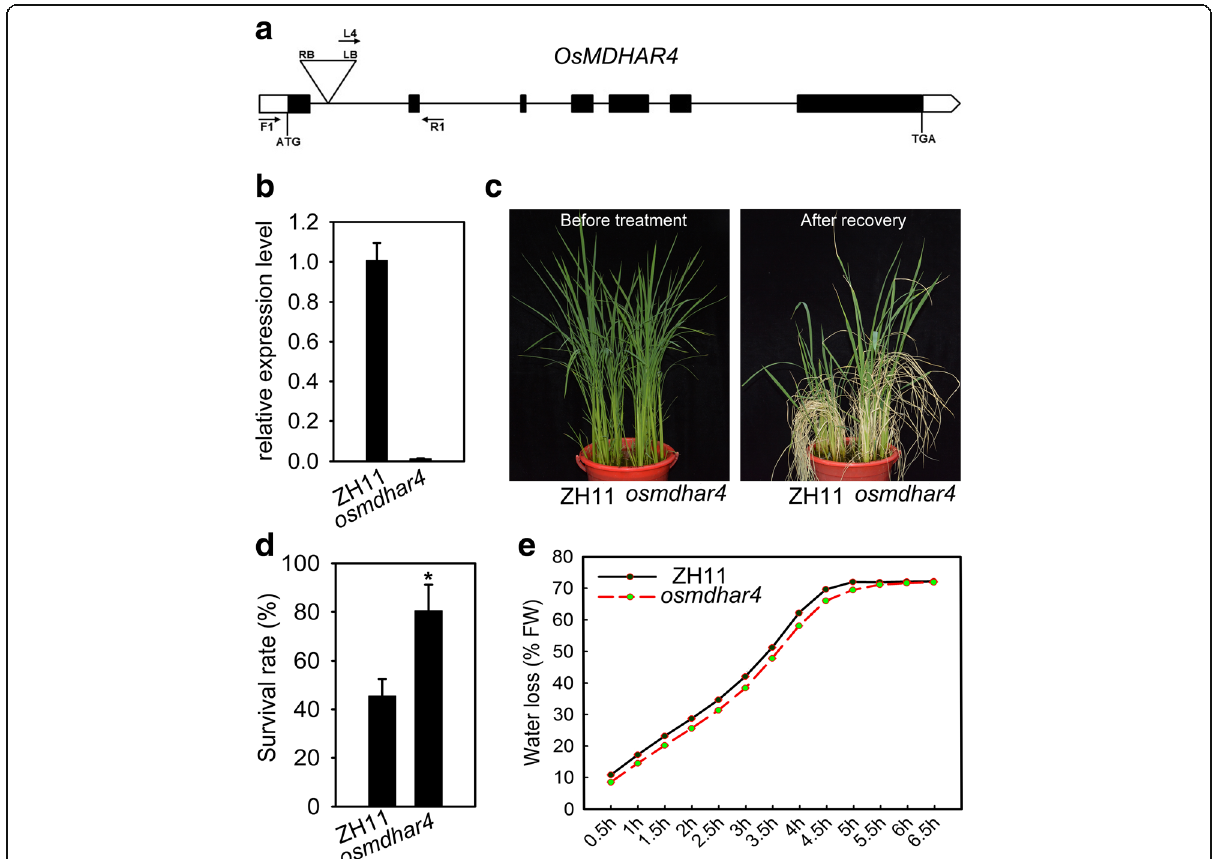
Fig. 3 Increased heat tolerance of the osmdhar4 mutant at seedling stage. a Schematic diagram of the OsMDHAR4 gene. In the genomic DNA, exons, introns, and untranslated regions are indicated by black boxes, lines between boxes, and white boxes, respectively. The T-DNA insertion site is located in the first intron, 254 bp downstream of the start codon ATG. LB, left border of the T-DNA; RB, right border of the T-DNA. Arrows F1, R1, and L4 represent the primers used in the genotyping of the osmdhar4 mutant. b Expression analysis of OsMDHAR4 in the osmdhar4 mutant detected by qRT-PCR. The rice Actin1 gene was used as the internal control. Error bars indicate the SE based on three technical replicates. c 5.5- to 6.5-leaf stage WT and the osmdhar4 mutant plants were growing in barrels filled with well-mixed soil. The left and right half of each barrel was planted with WT and mutant plants, respectively. Plants were treated with high temperature (45 °C) for 72 h, followed by culturing under normal conditions for 7 d. The photograph was taken before heat stress and after recovery. d Comparison of survival rates of WT and the osmdhar4 mutant after heat stress. Error bars indicated the SE based on three biological replicates. *, P < 0.05, by Student ’ s t -test. e Water loss from detached leaves of WT and the osmdhar4 mutant at indicated time points. FW, Fresh